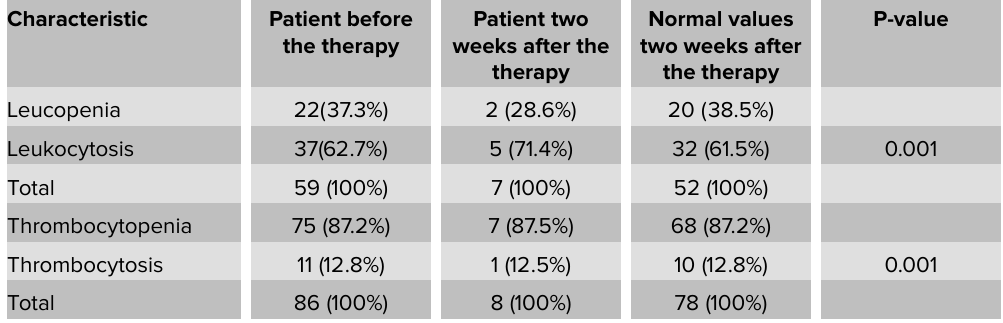
Table 3: Patients response to anti-malaria